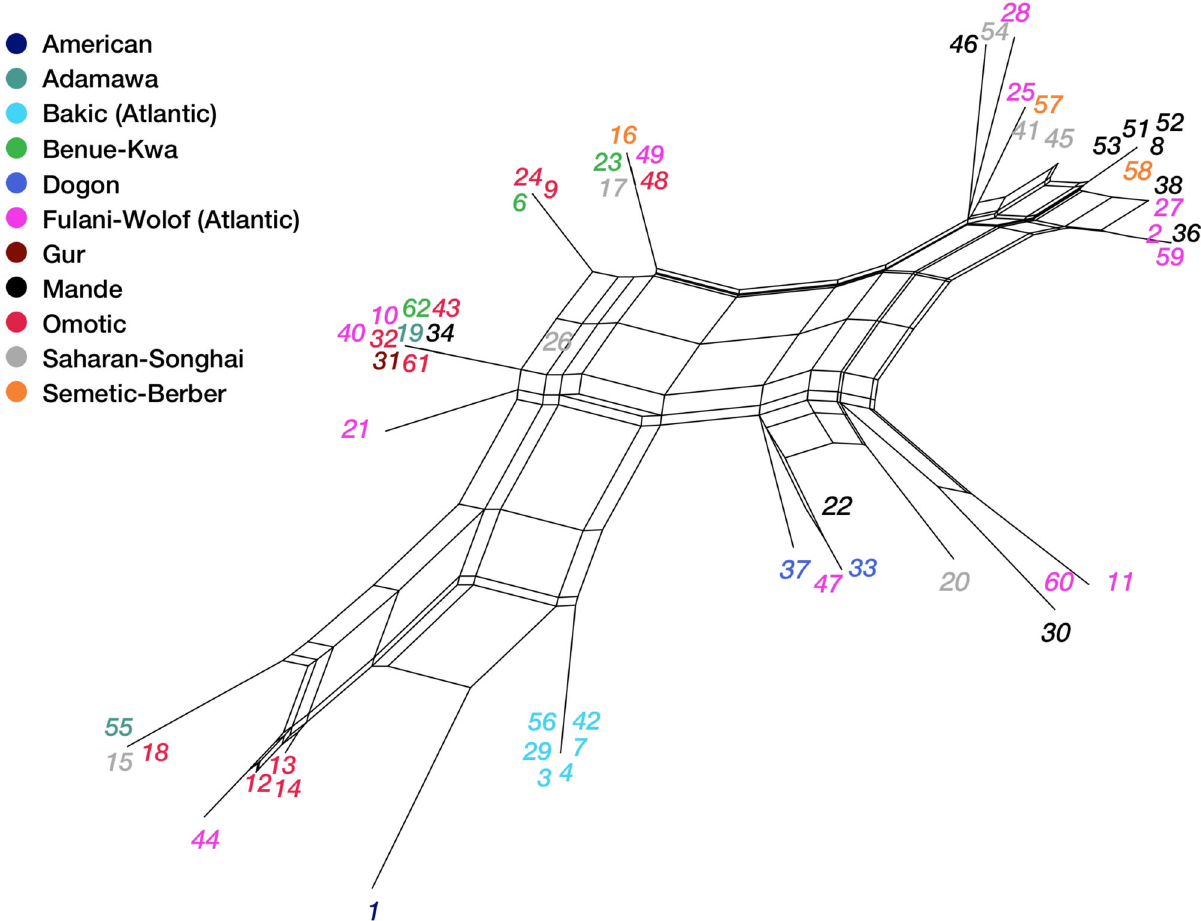
Fig. 5 NeighborNet plot by language. NeighborNet of instruments, labeled by language group (Saharan-Songhai language groups and Berber-Semitic language groups each combined for plotting clarity). Instrument labels as coded into taxon-character matrix: (1) banjo, (2) bappe, (3) bunchundo, (4) busunde, (5) diassare, (6) duru, (7) ekonting, (8) gambare, (9) garaya1, (10) garaya2, (11) gesere, (12) gullum, (13) gulum, (14) gurmi, (15) gurumi1, (16) gurumi2, (17) gurumi3, (18) gurumi4, (19) gzopoli, (20) jurkel1, (21) jurkel2, (22) juru_kelenni, (23) kaburu, (24) kakanza, (25) kambre, (26) keleli, (27) kerona, (28) keronaru, (29) kisinta, (30) kola_lemme, (31) kologo, (32) komo, (33) kona, (34) konde, (35) koni1, (36) koni2, (37) konou, (38) kontingo, (39) kook, (40) kuban, (41) kubru, (42) kusunde, (43) kwamsa, (44) molo1, (45) molo2, (46) molo3, (47) molo4, (48) molo5, (49) moolooru, (50) n_dere, (51) n_goni, (52) n_goni_ba, (53) n_goni_micin, (54) n_jurkel, (55) ngulan, (56) nopata, (57) teharden, (58) tidinit, (59) xalam, (60) xalam_gesere, (61) yakandi, and (62) Table 2). This underlines the heterogenous cultural in fl uences